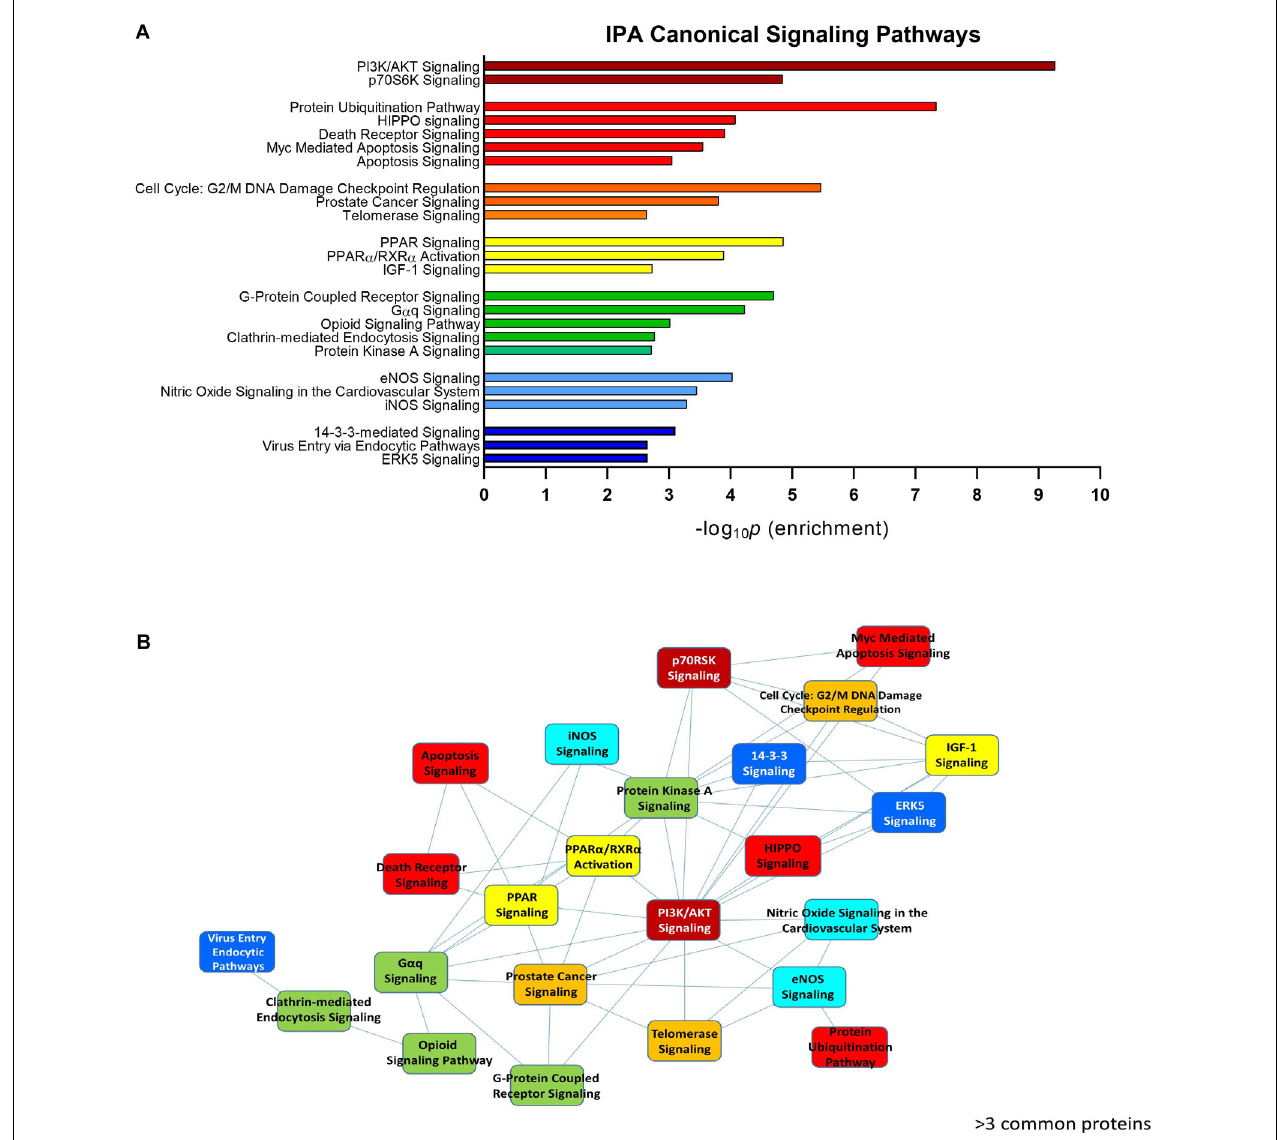
FIGURE 4 | IPA-assisted canonical signaling pathway analysis for the GRK5 interactome. The canonical signaling pathway suite of IPA was employed to generate a signaling cascade appreciation of the functional activity of the GRK5 interactome. (A) Indicates the top 20 most significantly ( p < 0.05) enriched canonical signaling pathways generated with our curated GRK5 interactome. The pathways are color coded and clustered into different functional groups. The close association between these 20 pathways (mediated by common proteins involved in multiple signaling pathways: ≥ 3 proteins in common) is depicted by the pathway network diagram in (B)